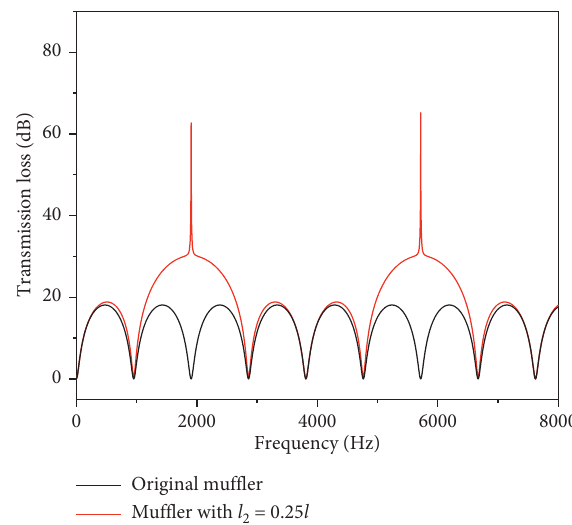
Figure 10: Transmission loss of the side outlet muffler and the original muffler ( l 2 � 0.25 l ).